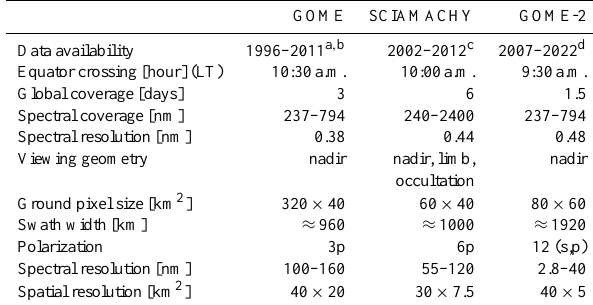
Table 1. Technical specifications of the instruments used in this work. The bottom part of the table describes the polarization mea- suring devices